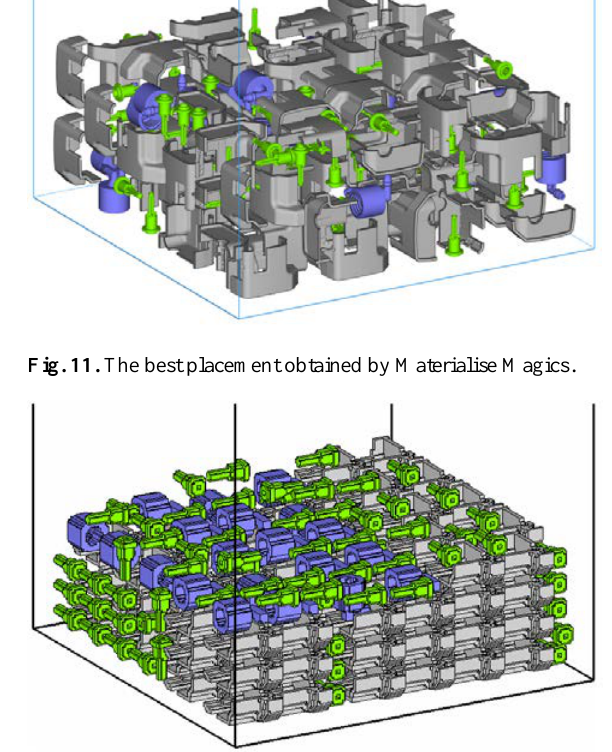
Fig. 12. Placement of orthogonal polyhedrons (decomposed voxelized objects) obtained by the developed algorithms .